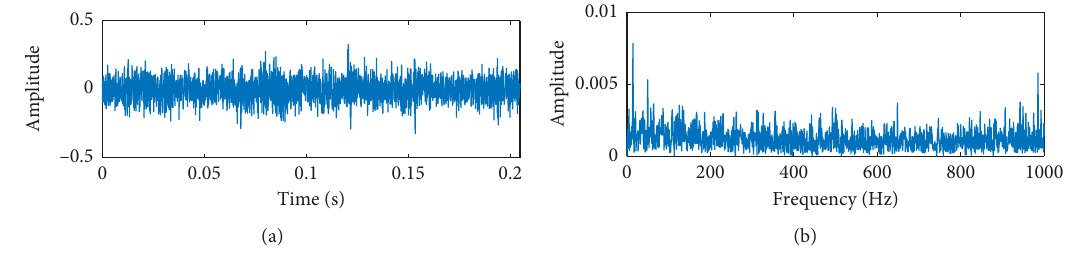
Figure 21: The life cycle fault signal: (a) TW; (b)